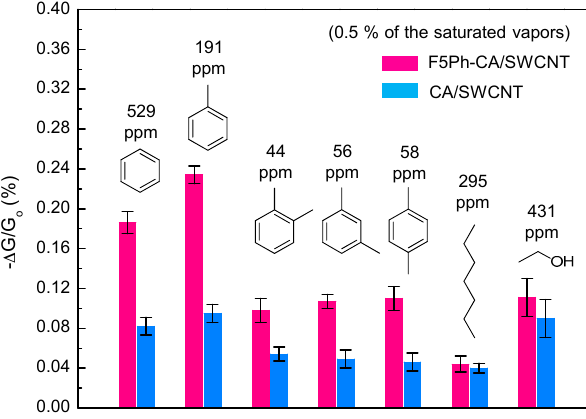
Figure 7. Selectivity chart displaying the responses of the F5Ph-CA/SWCNT and CA/SWCNT systems towards BTX vapors and n -heptane and ethanol as interferents. The concentrations of the analytes were 0.5% of the saturated vapors.